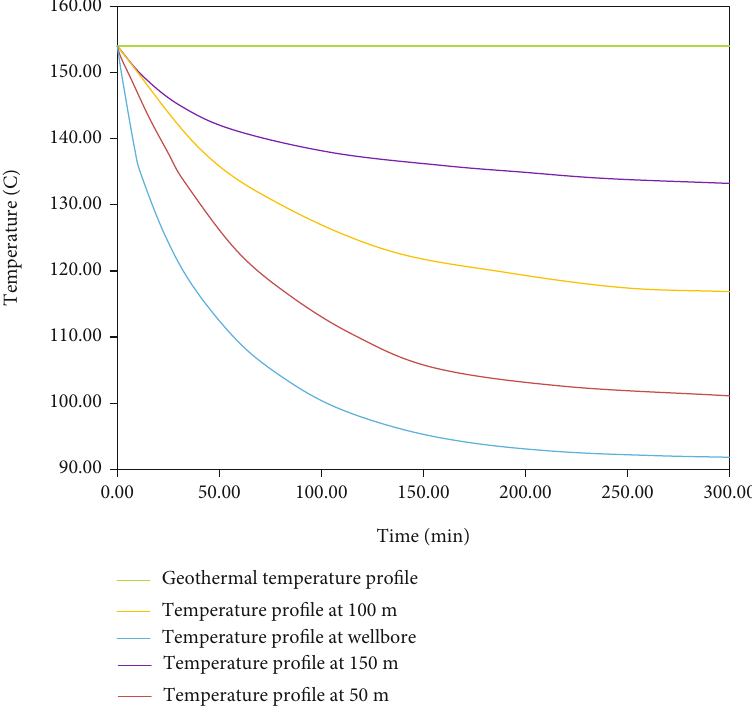
Figure 3: Temperature pro fi le with time at the formation.